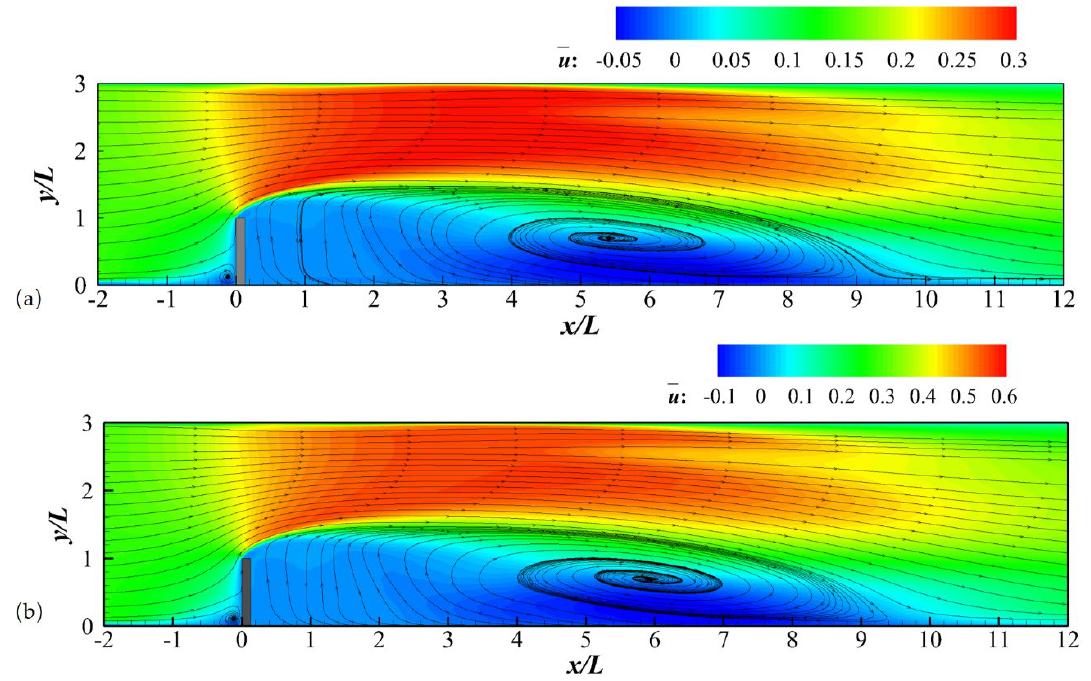
Figure 5. Distribution of time − averaged streamwise velocity with streamlines in the horizontal plane near the bed at ( z/H = 0.05) as computed for ( a ) Case 1 and ( b ) Case 2.